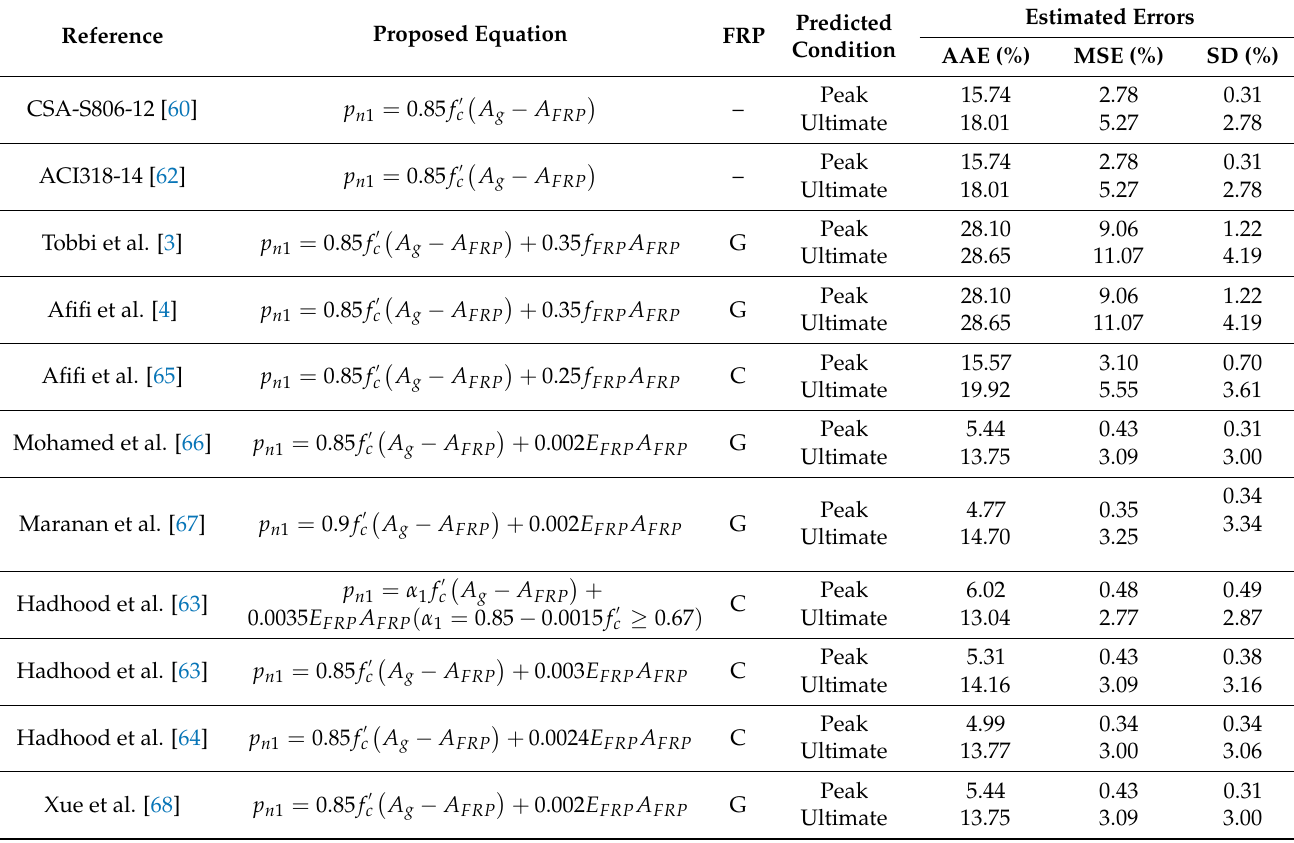
Table 1. Summary of the design equations available in the literature for FRP-RC